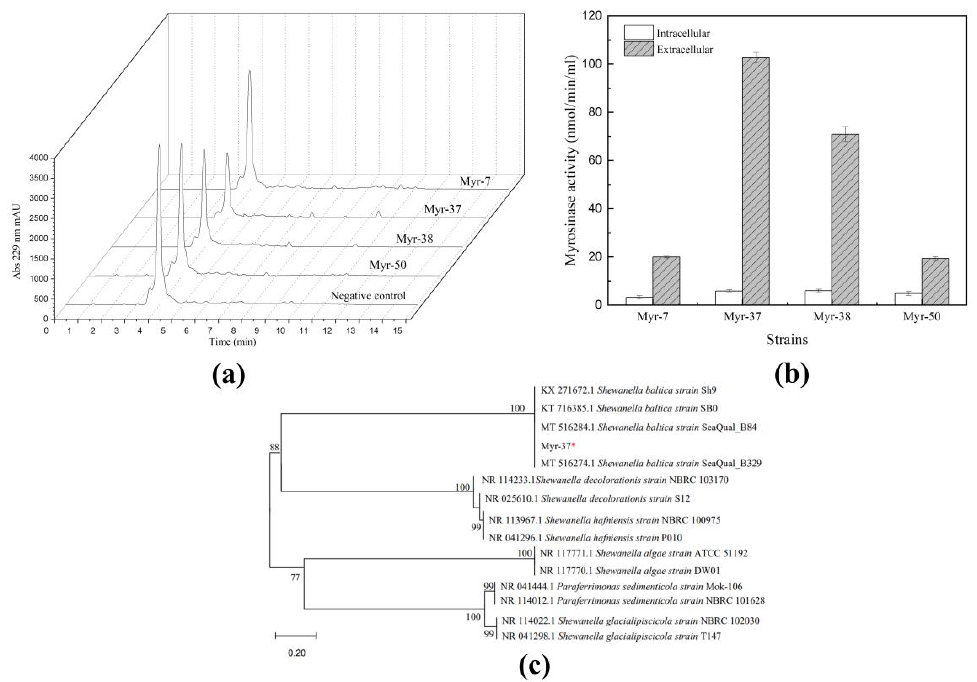
Figure 2. Shewanella baltica Myr-37 is capable of producing myrosinase. ( a ) High-performance liquid chromatography analysis at 229 nm of the sinigrin content in the fermentation broth. ( b ) Myrosinase activity of different strains. ( c ) Phylogenetic analysis of Myr-37 strain constructed using the neighbor- joining method based on 16S rRNA gene sequences. *: the strain isolated in our